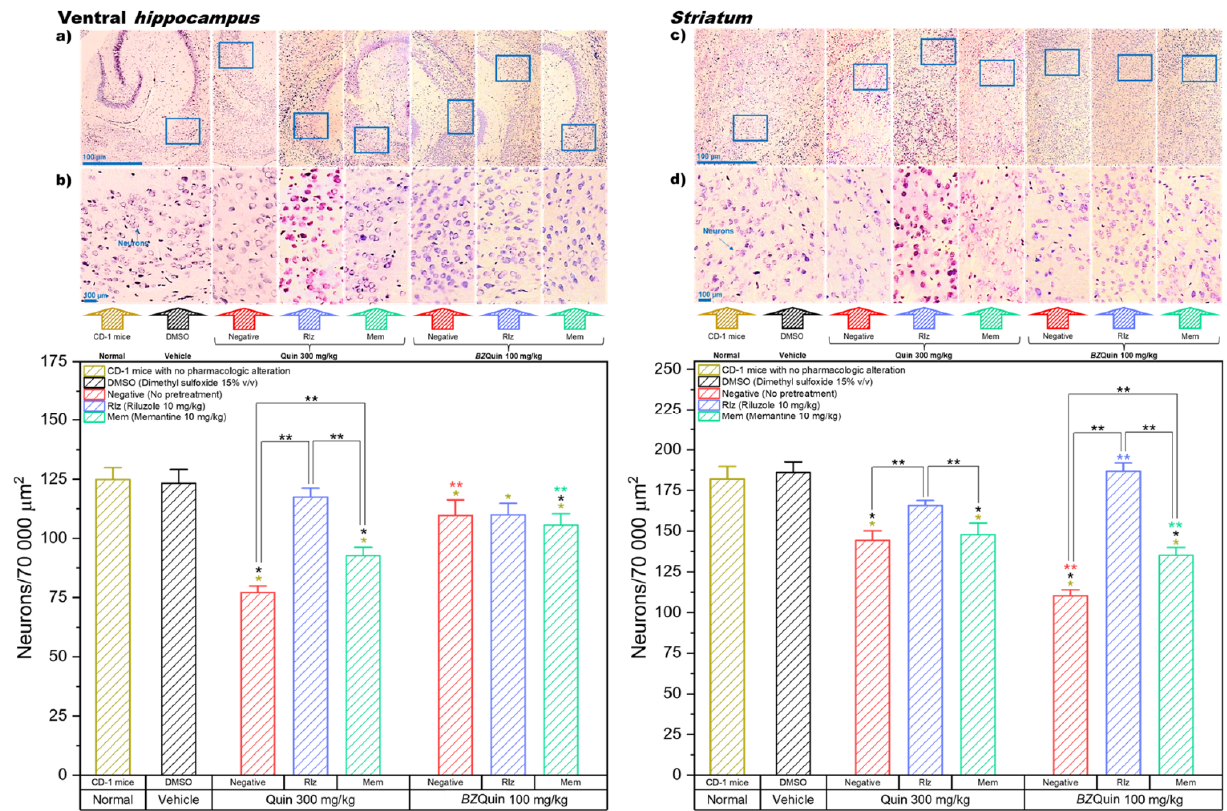
Figure 10. Left. Ventral hippocampus (neuron count in the CA1 region): * p < 0.001 compared to the normal group; * p < 0.001 compared to the vehicle group. Neurons/70,000 μ m 2 (pretreatment): Rlz > Mem > negative, p < 0.001. Neurons/70,000 μ m 2 (stimulating agent): BZQuin 100 mg/kg > Quin 300 mg/kg, p < 0.001. ** p < 0.01. ** p < 0.001 compared to the negative group with Quin at 300 mg/kg. ** p < 0.01 compared to the Mem group with Quin 300 at mg/kg. Micrographs at magnifications of ( a ) 4× and ( b ) 20×. Right. Striatum (neuron count): * p < 0.001 compared to the normal group; * p < 0.001 compared to the vehicle group. Neurons/70,000 μ m 2 (pretreatment): Rlz > Mem > negative, p < 0.001. Neurons/70,000 μ m 2 (stimulating agent): Quin 300 mg/kg > BZQuin 100 mg/kg, * p < 0.01. ** p < 0.01. ** p < 0.001 compared to the negative group with Quin at 300 mg/kg. ** p < 0.001 compared to the Rlz group with Quin at 300 mg/kg. ** p < 0.05 compared to the Mem group with Quin at 300 mg/kg. Micrographs at magnifications of ( c ) 4× and ( d ) 20×.